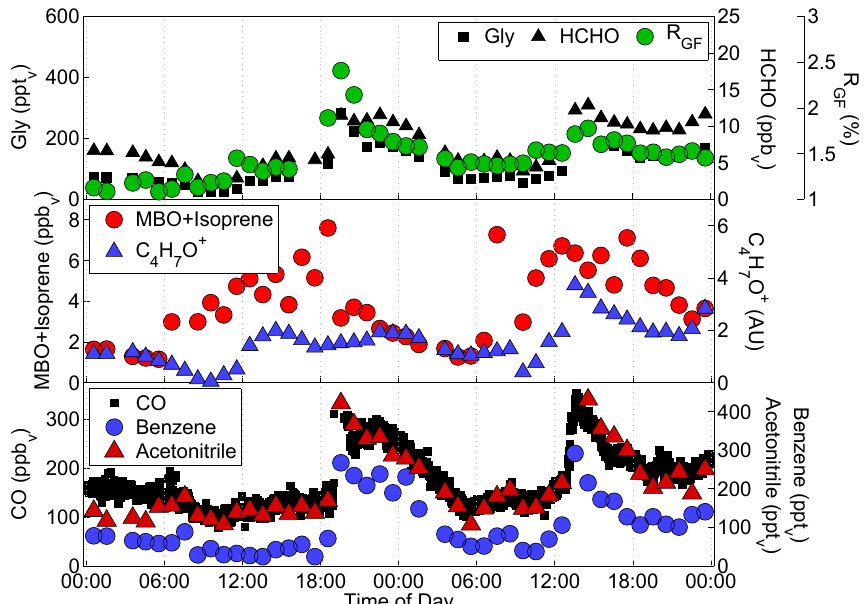
Fig. 2. Gly, HCHO, R GF and other tracer species during the two days of the MFI (DOY 197 & 198). Gly, HCHO, and R GF are shown as 30 min binned averages ( ± 15 min each half hour), whereas other species are shown at full resolution. Data for MBO+Isoprene, C 4 H 7 O + , benzene, and acetonitrile were measured via